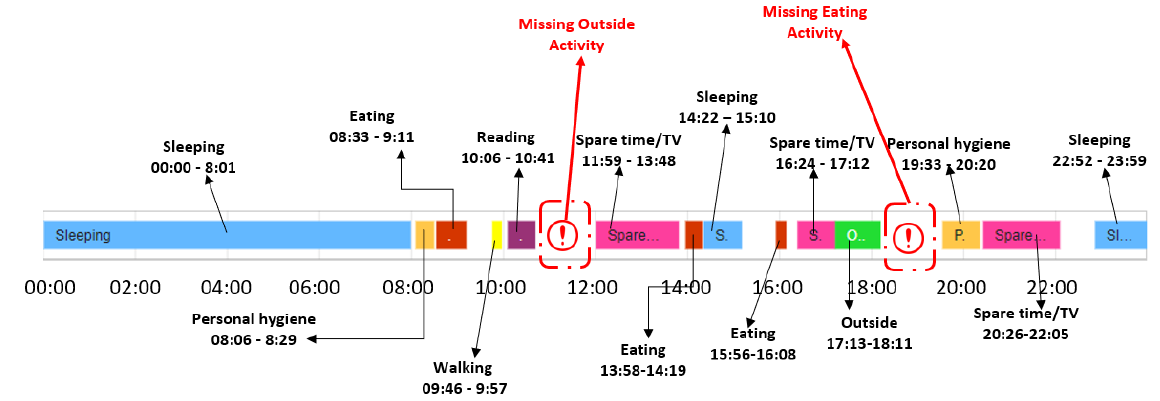
Figure 10. Example of day with activity sequence anomalies for the older adult M1.